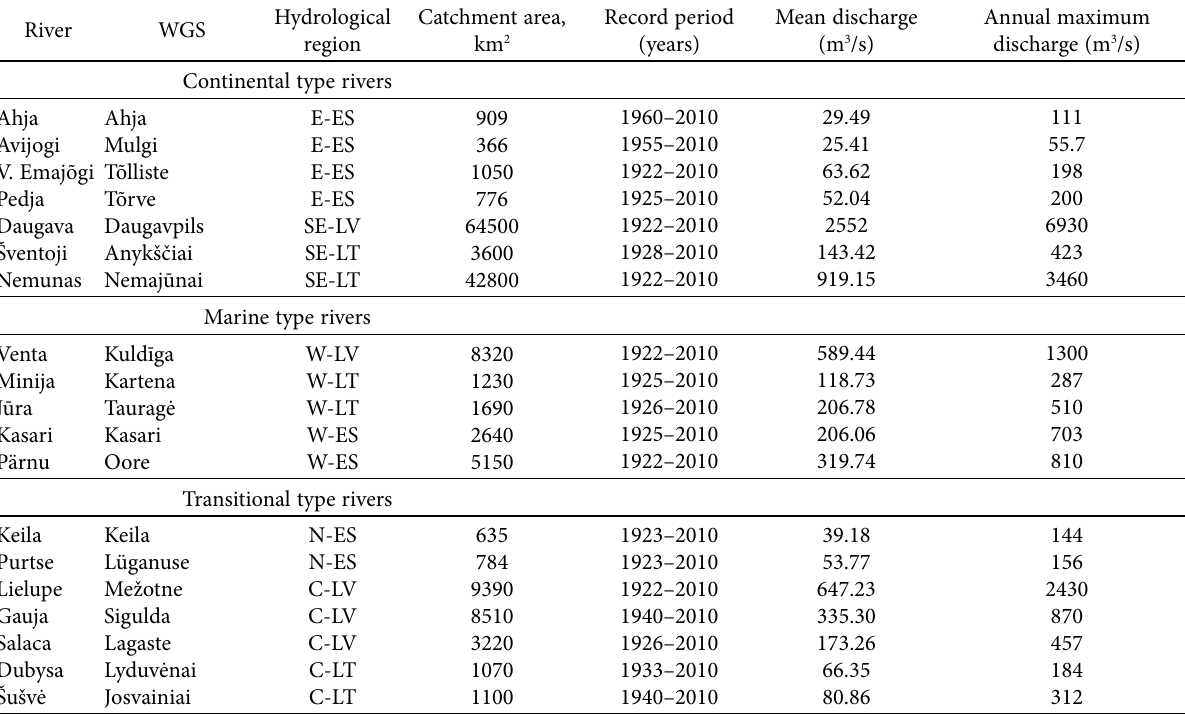
Table 2. Description of the river data